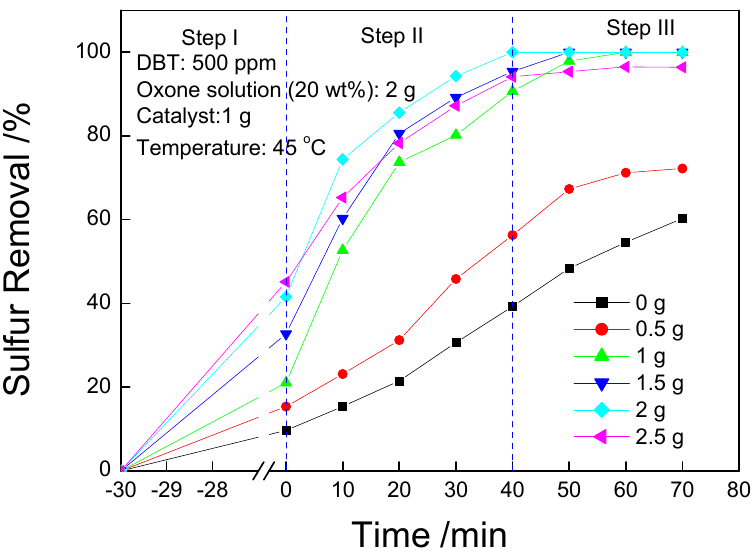
Figure 7. Effect of [BMIM]BF 4 dosage.